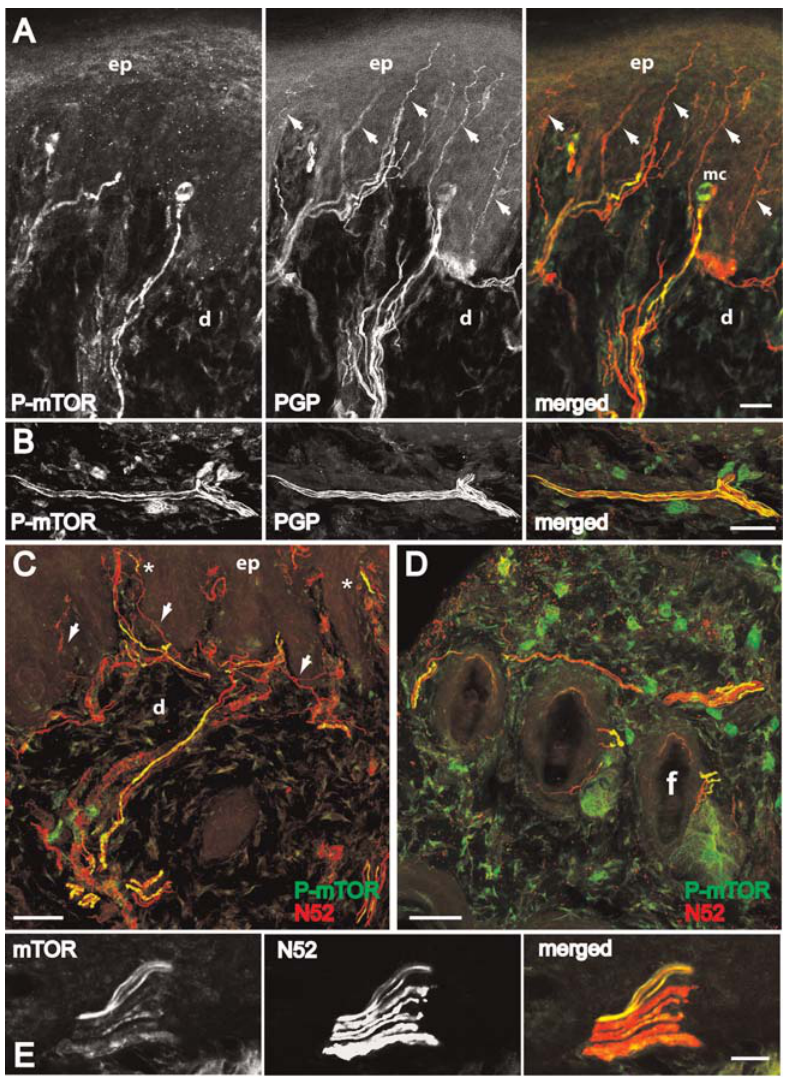
Figure 1. Distribution of mTOR immunoreactivity in peripheral sensory nerve fibers in the skin. Confocal images of 40 m M thick frozen sections cut perpendicular to the skin surface of the rat hindpaw. A , B , Colocalization of phospho-mTOR ( green ) and nerve fibers marker PGP ( red ), a general marker of nerve fibers, in footpad of glabrous skin. Arrows indicate PGP- positive fibers not double-labelled. C , D , Colocalization of phospho- mTOR ( green ) and myelinated fiber marker N52 ( red ) in footpad of glabrous skin (C) and hairy skin (D) . Arrows in C indicate N52- positive fibers not double-labelled. Asterisks (*) indicate double-labelled fibers in the area of Meissner corpuscles (sensory receptors within dermal papillae). E , Colocalization of phospho-mTOR and N52 in the dermis of the glabrous skin. In A , B and E the single staining for each antibody and the merged image are shown from left to right. In A-E double staining appears in yellow . mc, Meissner corpuscles; ep, epidermis; d, dermis; f, follicle. A , E , single focal planes; B-D , merge of 22–24 z-focal planes (20–21 m m depth). Scale bars, A-E : 50 m m. doi:10.1371/journal.pone.0001961.g001 individual primary afferent sensory fibers, we used the skin nerve injection, compared to control injections of appropriate vehicle preparation [38,39]. (Fig. 5; P , 0.05, Bonferroni post-hoc test; supplementary Fig. S1B). In contrast, paw withdrawal thresholds to slow heat ramps (activating C- fiber nociceptors) remained unchanged after